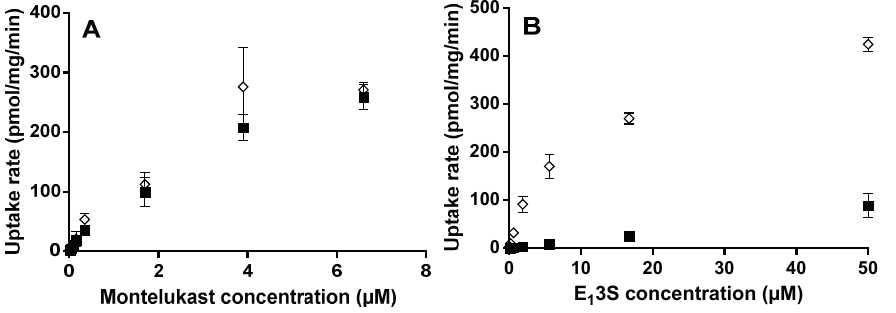
Figure 1. Concentration-dependent uptake of montelukast ( A ) and E 1 3S ( B ) in HEK- OATP2B1 ( ◊ ) and HEK-mock ( ■ ) at pH 6.5. Results are given as mean ± S.D., n =